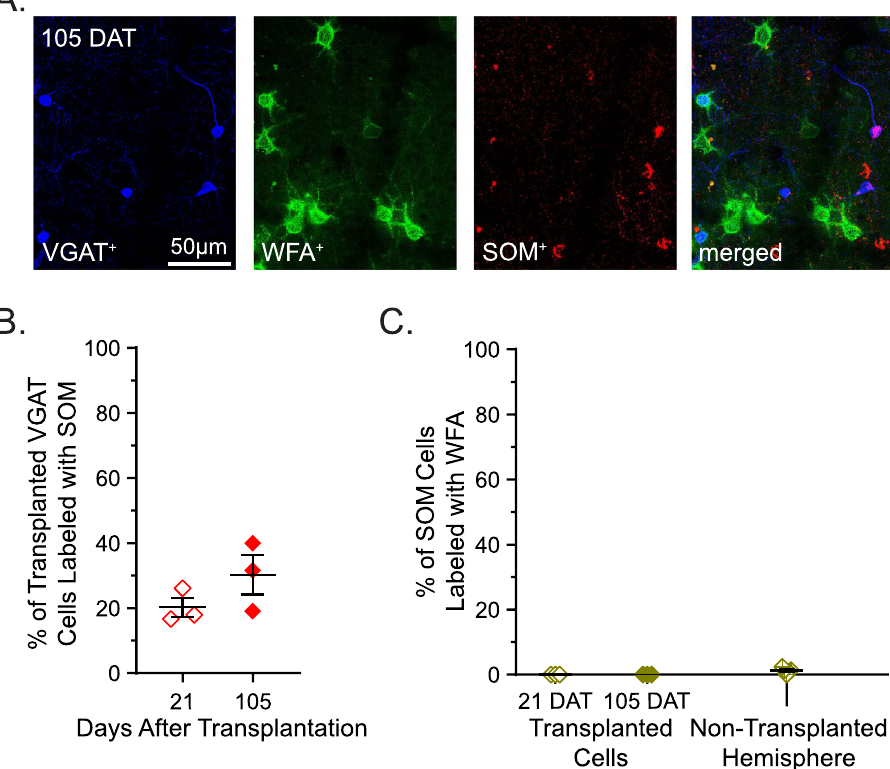
Figure 5. PNNs are not associated with transplanted SOM inhibitory neurons. ( A ) Example sections of primary visual cortex from transplant recipients at 21, 35, and 105 DAT. Transplanted VGAT neurons (blue) are stained with WFA (green) and SOM (red). ( B ) The percentage of transplanted SOM cells 21 and 105 DAT (21 DAT = 30.23 ± 6.07 (open), 105 DAT = 20.23 ± 2.95 (filled)). ( C ) Transplanted and host SOM cells are not co- labeled with WFA (21 DAT = 0 ± 0 (open), 105 DAT = 0 ± 0 (filled), N-TH = 1.22 ± 0.38 (crossed)) n 21DAT = 105 VGAT cells, 6 sections, n = 3 mice; n 105DAT = 116 VGAT cells, 3 sections, 3 mice; n N-TH = 421 SOM cells, 5 slices, 5 mice. Error bars represent